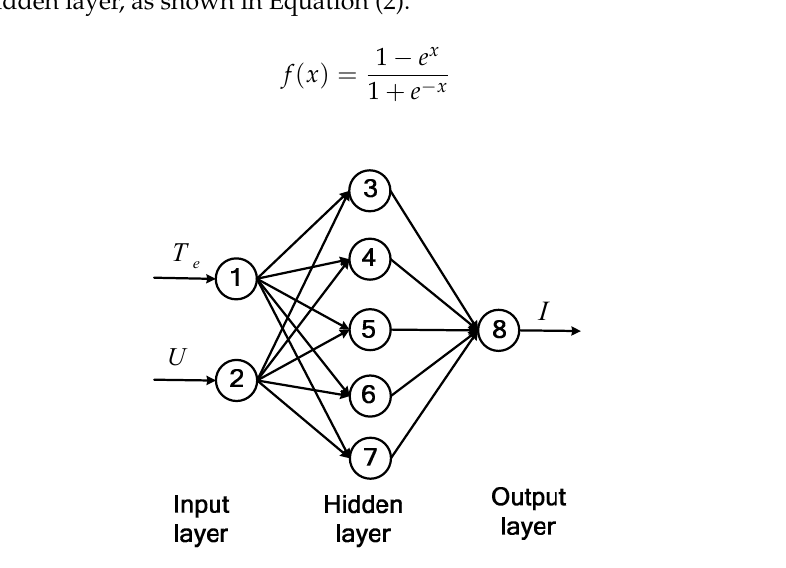
Figure 5. Diagram of the artificial neural network (ANN) algorithm.